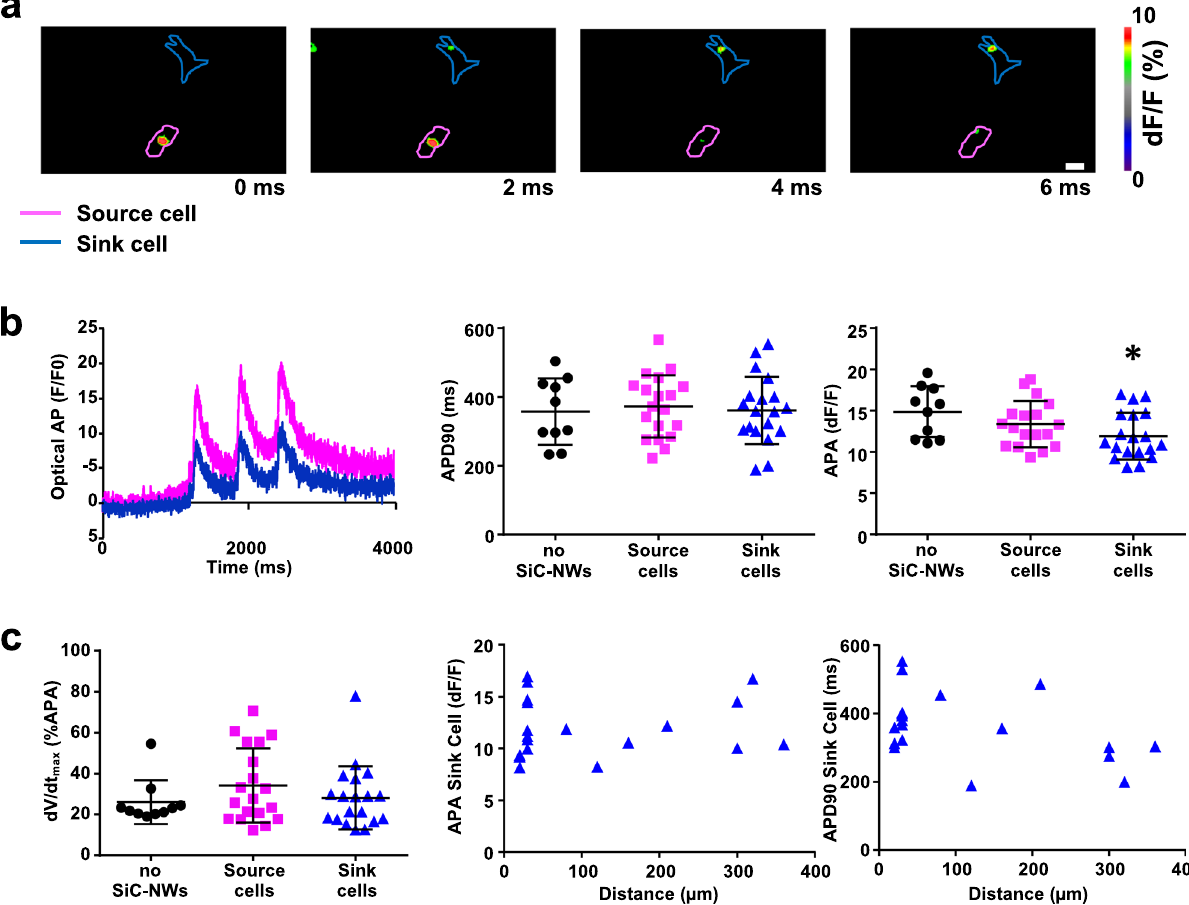
Fig. 4 Electrotonic optical action potential synchronization over distance in synthetically coupled cells. a Color-coded images of an optical action potential spontaneously initiated in the pink HL1 cell (source) and rapidly propagating via SiC-NWs, to the blue HL1 cell (sink); ×20 magni fi cation, scale bar = 10 μ m. n = 19 experiments repeated with similar results. b Left Panel. Representative spontaneous APs propagated from a source cell (pink) to a sink cell (blue). n = 19 experiments repeated with similar results. Middle Panel. Optical AP duration calculated at 90% of repolarization in control HL1 cells (no SiC-NWs, n = 10, black dots), source cells ( n = 19, pink squares), and sink cells ( n = 19, blue triangles). Right Panel. Same as Middle Panel for AP amplitude. c Left Panel. Maximal upstroke velocity (dV/dt max ) calculated in controls ( n = 10, black dots), sources ( n = 19, pink squares) and sinks ( n = 19, blue triangles). Middle Panel. AP amplitude values ( n = 19, blue triangles) for cell sinks vs. cell – cell distance. Right Panel. Action Potential duration values ( n = 19, blue triangles) for cell sink vs. cell – cell distance. Data are expressed as mean ± SD for the dot plots graphs, real values for the blue triangles graphs. Unpaired two-sided Student ’ s t -test. Statistical signi fi cance set at p < 0.05. * p = 0.01 vs no SiC-NWs. Source data are provided as a Source Data fi